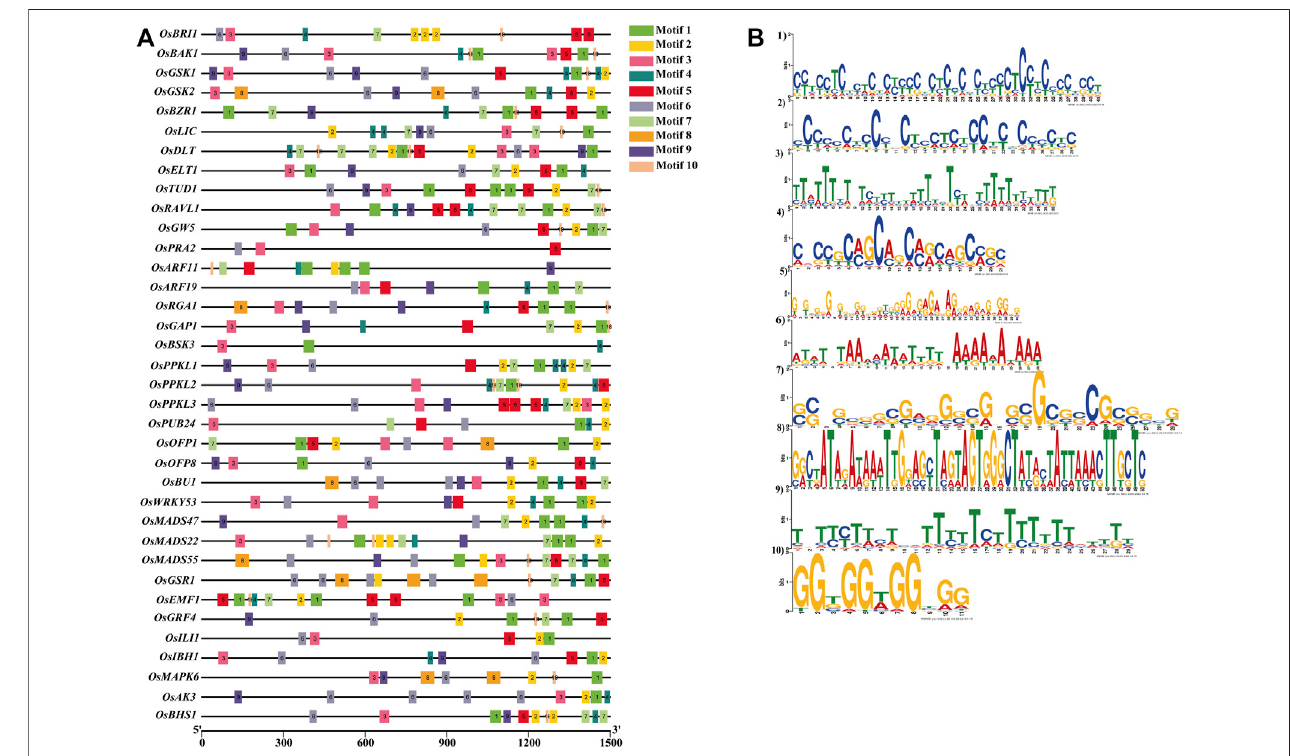
FIGURE 6 | (A) Localization of conserved motifs within promoters of the BR signaling genes. (B) Logo of the conserved motifs within promoters of the BR signaling